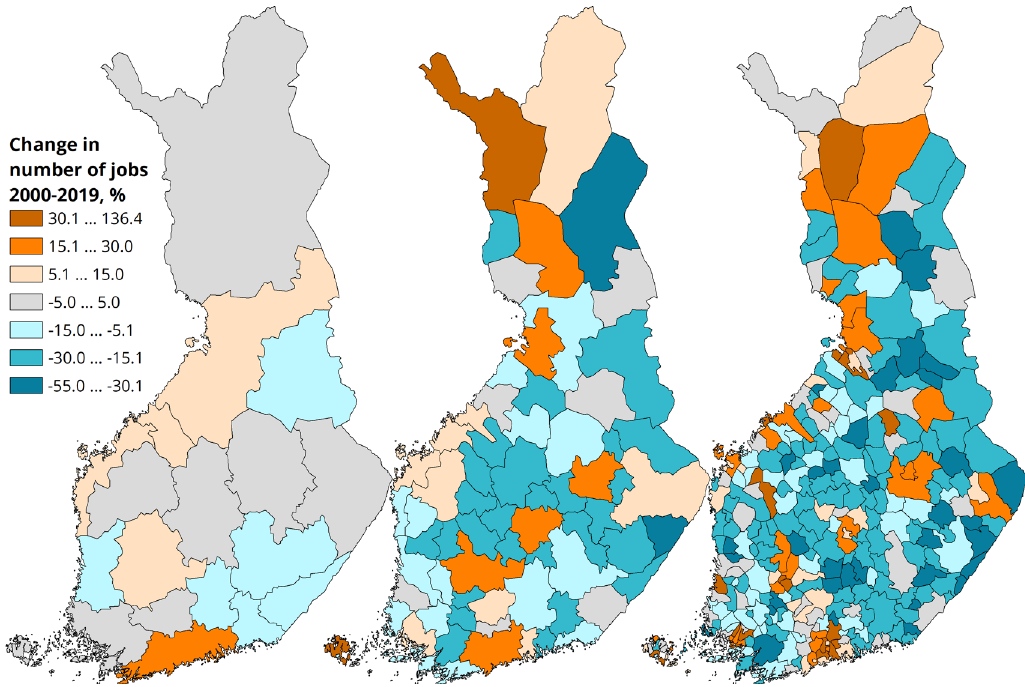
Fig. 9. Changes in regional employment (jobs) in Finland, 2000–2019.